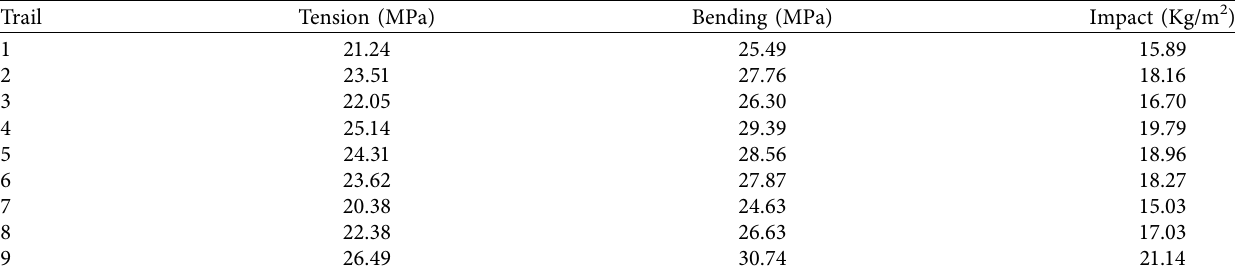
Table 3: Consequences of examination.